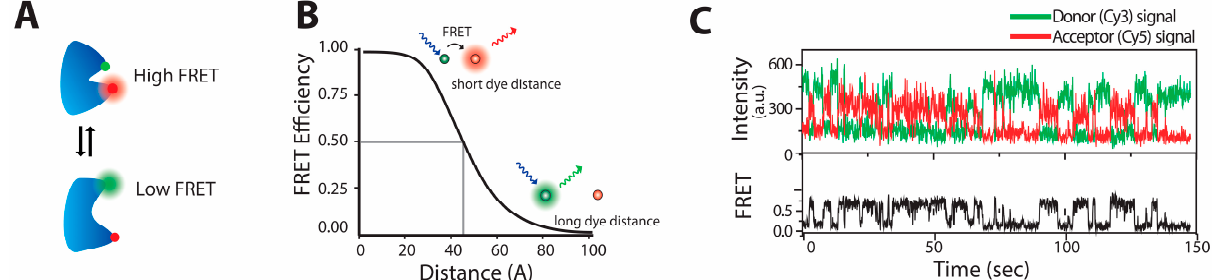
Figure 1. smFRET description ( A ) A biomolecule undergoing time dependent conformations motions changing the inter dye distance and hence the FRET readout; ( B ) Diagram of FRET efficiency, E, as a function of inter-dye distance (R) for a R 0 = 45 Å. The donor fluorophore when excited with laser either fluoresces or transfers a part of its energy to an acceptor fluorophore, depending on their distance. At distance equal to the Förster radius R = R 0 , E = 0.5. FRET changes are higher at distance variations around the Förster radius; ( C ) Typical time trace of single molecules (here DNA molecules) undergoing conformational fluctuations between two states recorded by fluorescence microscopy. Top trace shows the anticorrelated time traces of donor (green) and acceptor (red) molecules. Bottom trace shows the corresponding E FRET . (Figure 1C adapted with permission from